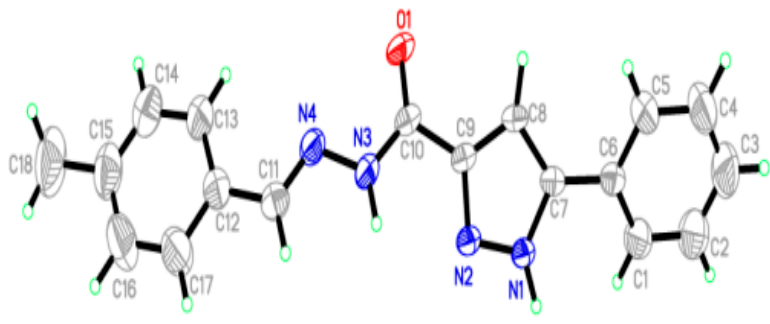
Figure 2. Asymmetric unit of L2 (CCDC 1523265).